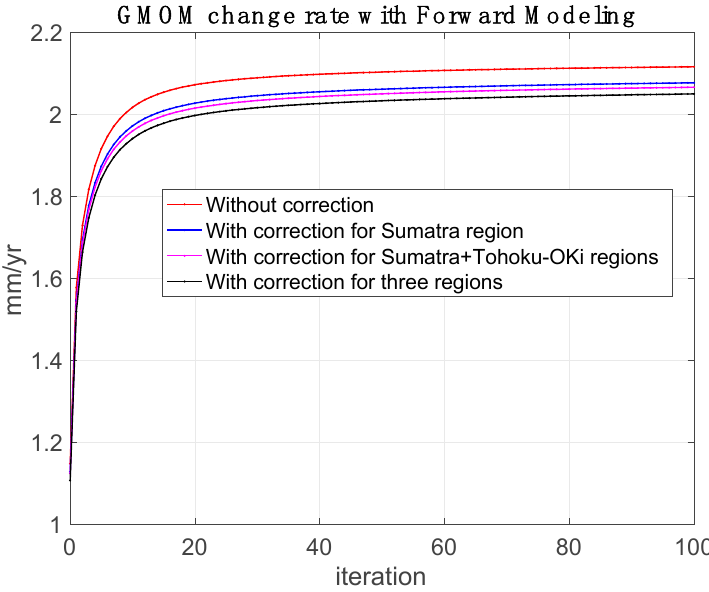
Figure 6. The global mean ocean mass (GMOM) change rates using forward modeling recovery after 100 iterations. The red curve represents the GMOM change rate without seismic correction. The blue curve denotes the GMOM change rate with correction for the Sumatra earthquake region. The magenta curve represents the GMOM change rate with the corrections for the Sumatra and Tohoku-Oki earthquake regions. The black curve denotes the GMOM change rate with the corrections for the three regions.